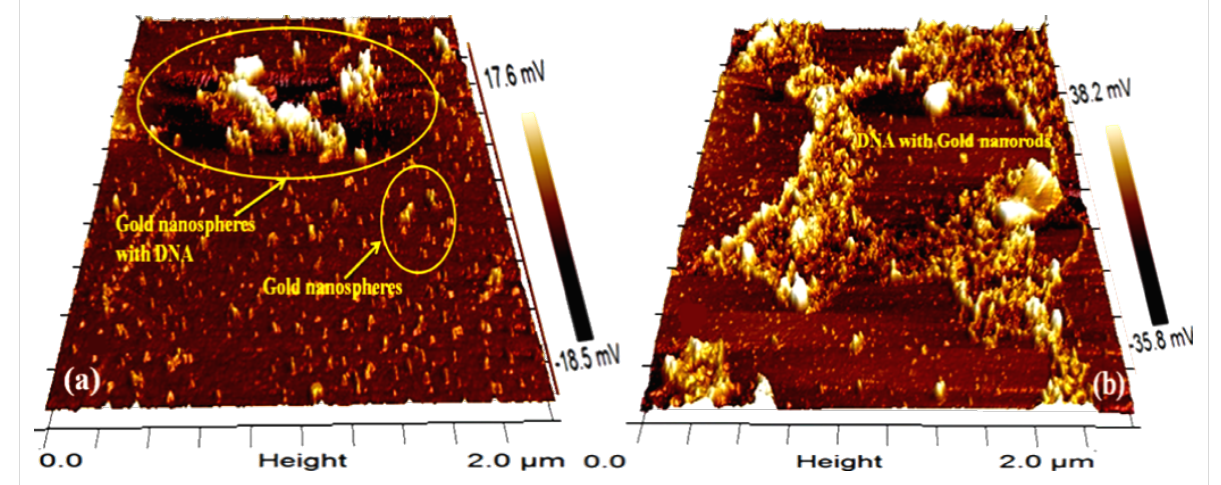
Figure 6: 3D AFM images of Au–DNA nanocomposites of (a) AuNSs and (b) AuNRs.